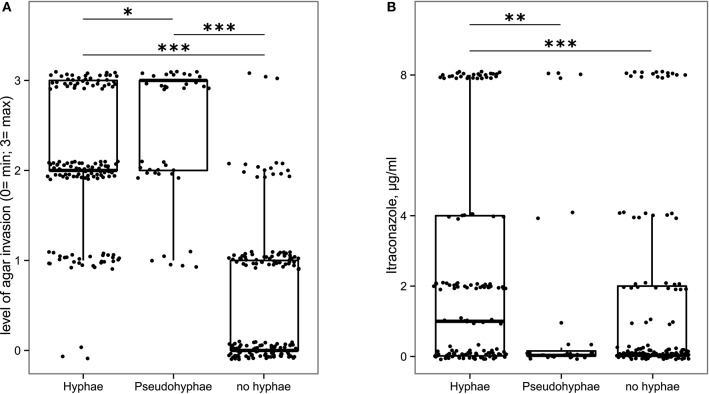
Box-plot representation of fungal isolates able (or not) to produce hyphae or pseudohyphae in relationship with (A) their ability to be invasive on YPD solid medium, (B) their resistance to itraconazole. *p < 0.05, **p < 0.005, ***p < 0.001, Wilcoxon rank-sum test.